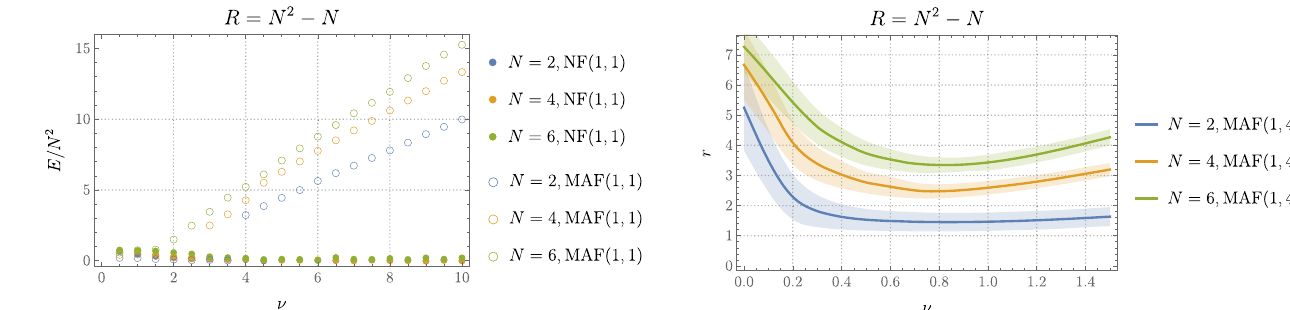
FIG. 8. Distribution of radius for different N and small ν . Bands show the standard deviation of the quantum mechanical distri- ffiffiffiffiffiffiffiffiffiffiffiffiffiffiffiffiffiffiffiffiffiffiffiffiffiffiffi p P bution of r ¼ tr X 2 , not to be confused with numeri- ð 1 =N Þ i cal uncertainty of the average. Recall that the numbers in the brackets are, first, the number of layers in the neural networks and, second, the number of generalized normal distributions in each base